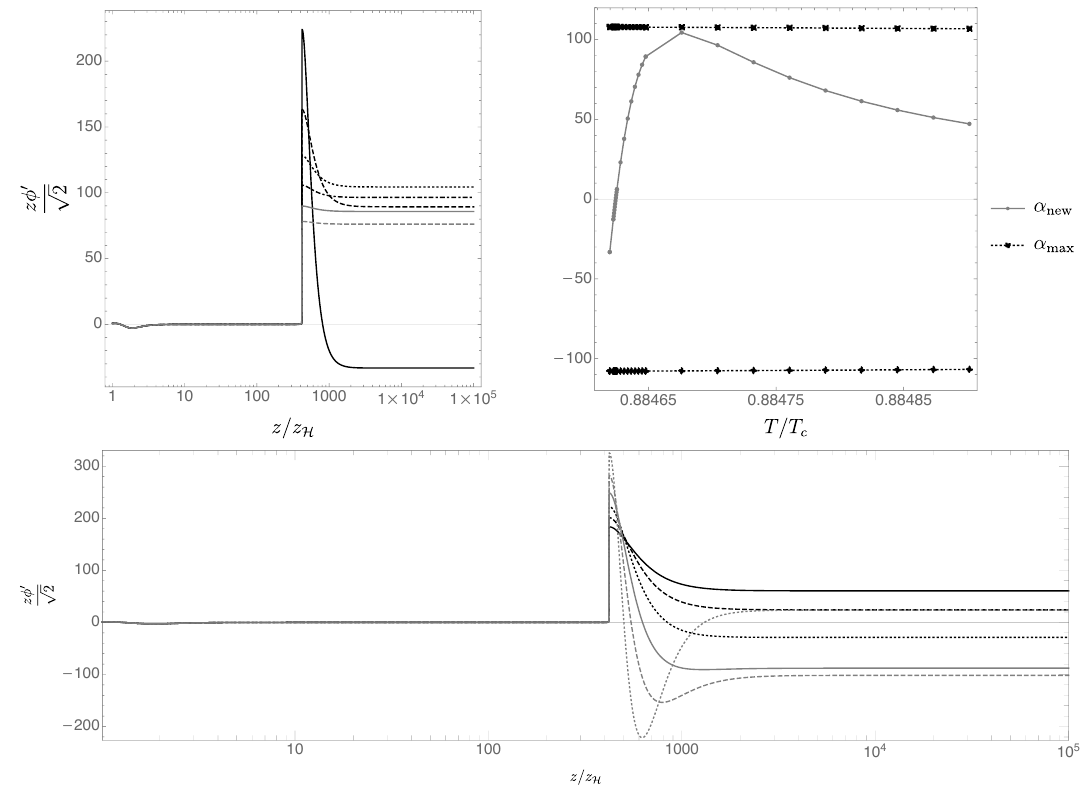
Figure 10: Approach to the bound (42) on α (top) and appearance of an os- new cillation at a Kasner inversion (bottom). In the upper left we plotted for tempera- = 0.88462 (solid black), 0.88465 (dashed black), 0.88468 (dotted black), tures T / T c 0.88470 (dot-dash black), 0.88473 (solid gray) and 0.88476 (dashed gray), showing the decrease in z φ (cid:48) after the inversion as the bound is approach. The lower figure has = 0.884684 (solid black), 0.884676 (dashed black), 0.884669 (dotted black), T / T c 0.884661 (solid gray), 0.884652 (dashed gray) and 0.884644 (dotted gray) in order to highlight the eventual emergence of oscillations after the second collapse. Notice the extreme sensitivity of the new value α on the new